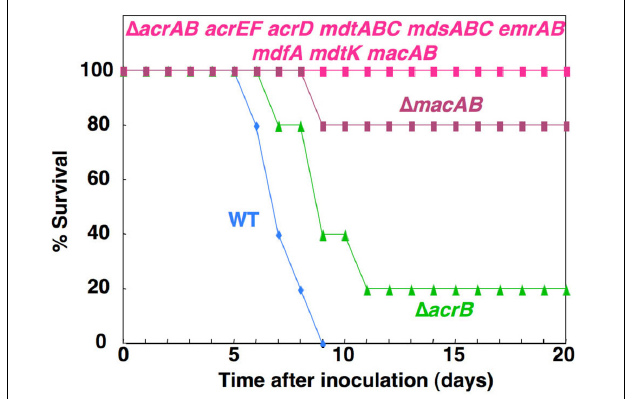
FIGURE 3 | The effect of Salmonella drug efflux pump on the virulence. This figure shows the survival rates of BALB/c mice inoculated intragastrically with 10 6 colony-forming units of each Salmonella